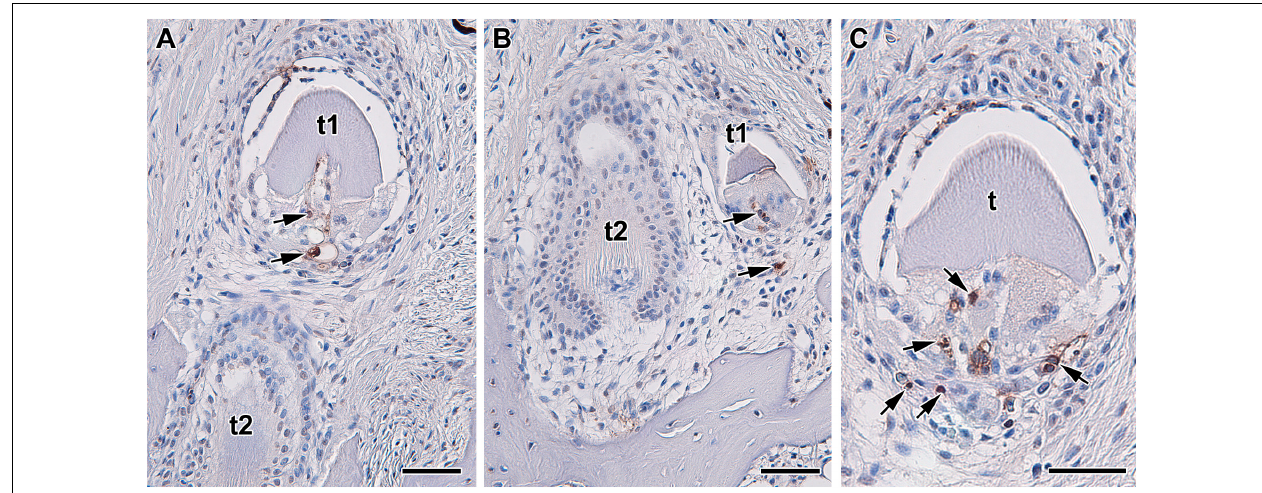
FIGURE 3 | Localization of apoptotic cells during tooth replacement. (A–C) Apoptotic cells (arrows) are located in the dental papilla and underlaying area of dental follicle in teeth in regression. Apoptosis was labeled by TUNEL assay in transversal section through upper jaw of Xenopus tropicalis t1, t2 - teeth. TUNEL-positive cells (brown, DAB), TUNEL-negative cells (blue, Hematoxylin). Scale bar = 50 µ m.